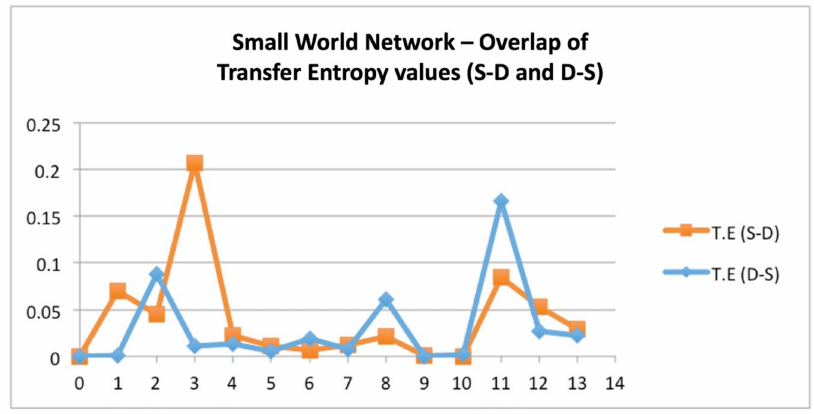
Figure 7. Transfer entropy values between the nodes of small world